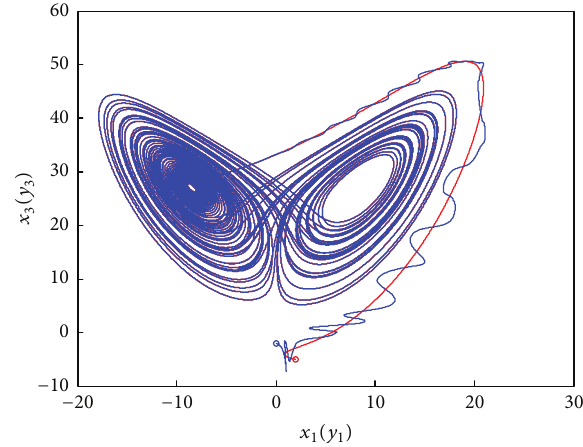
Figure 6: Attractors of complete projective synchronization with different conditions between the Lorenz system and the L¨u system.